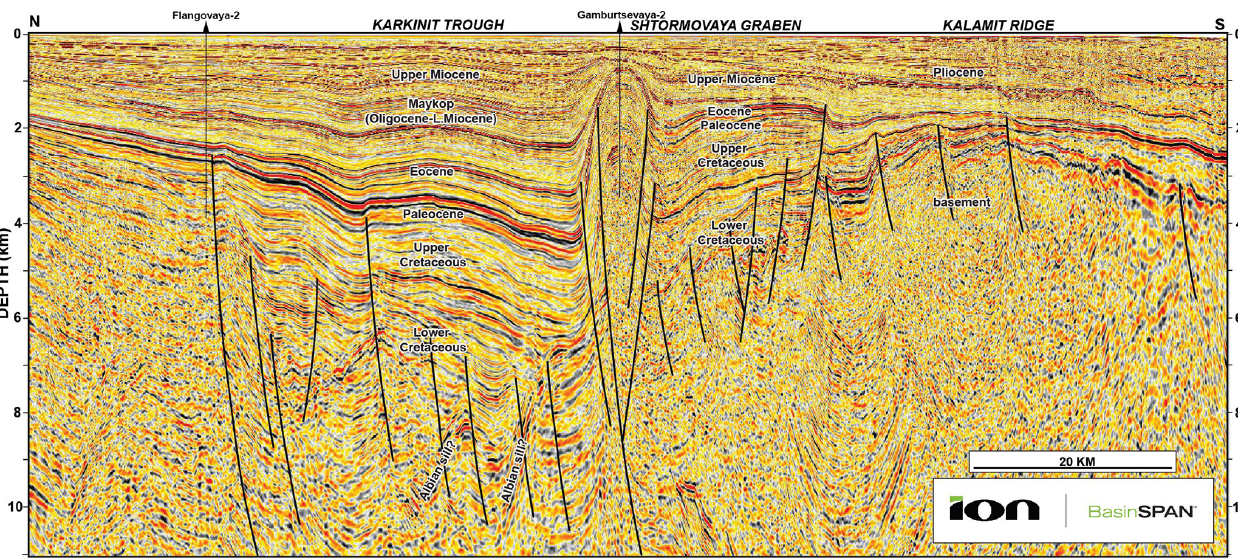
Figure 10. Regional-scale pre-stack depth migrated (PSDM) seismic reflection profile across the Odessa Shelf, courtesy of ION. For location, see Fig. 8. Note the > 7500m deep Karkinit trough in the middle of the section and the Kalamit ridge to the south of it. Approximately five times vertical